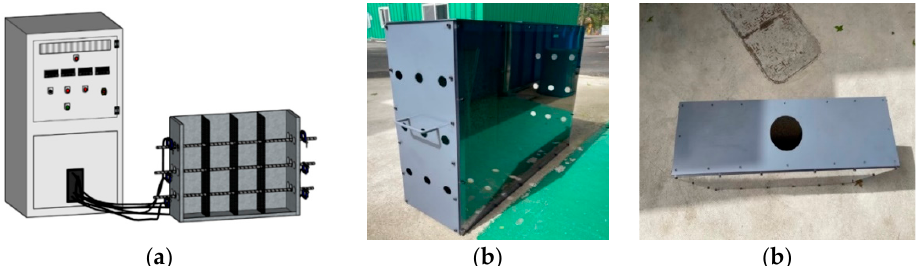
Figure 3. Diagram of ( a ) electrical resistance heating device; ( b ) side view of soil container; ( c ) top view of soil container.